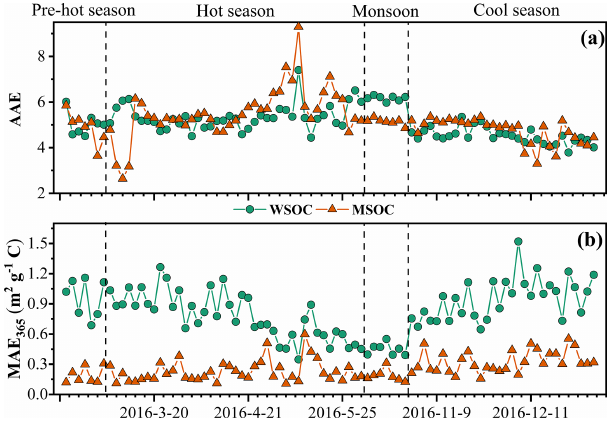
Figure 4. Time series plots of the absorption Ångström exponent (AAE, a ) as well as the mass absorption efficiency at 365nm (MAE 365 , b ) in the water-soluble organic carbon (WSOC) and methanol-soluble organic carbon (MSOC) in aerosols samples from Bangkok in Thailand during